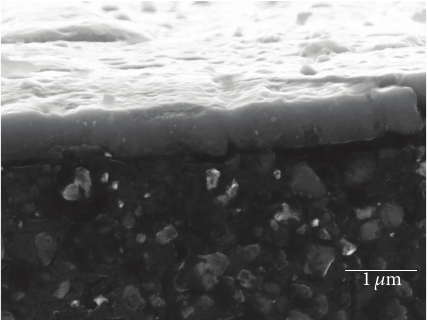
Figure 3: CrN surface